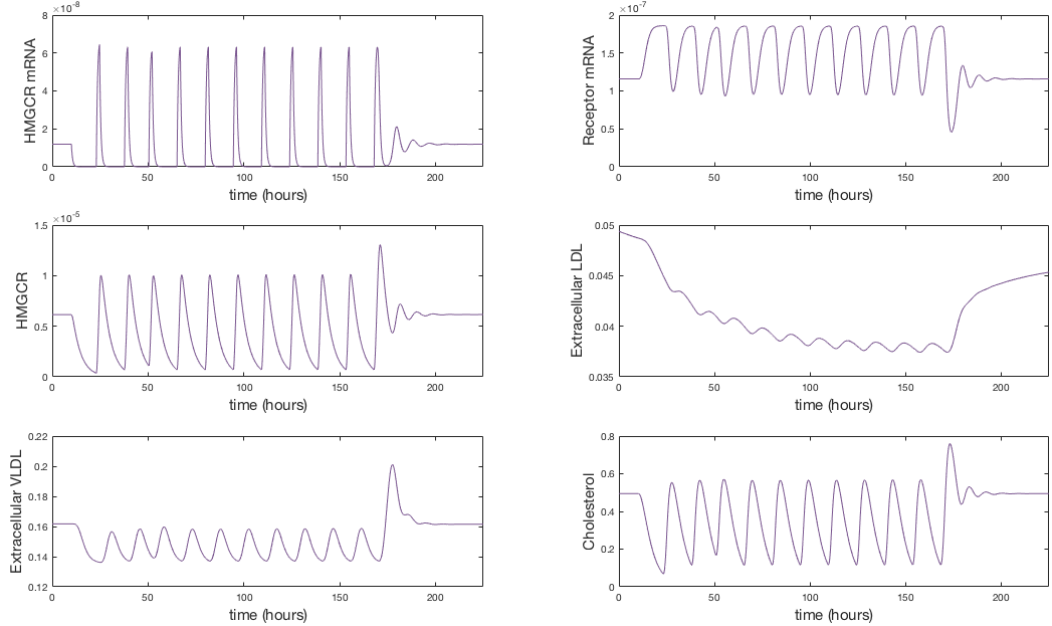
Figure 5. A simulation showing the effect of statin therapy on our integrated model of cholesterol metabolism. Here 11 doses are applied over a seven day period starting at approximately t = 10